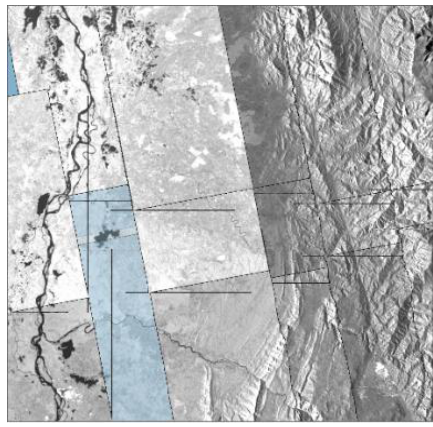
Figure 2 - TerraSAR-X coverage over